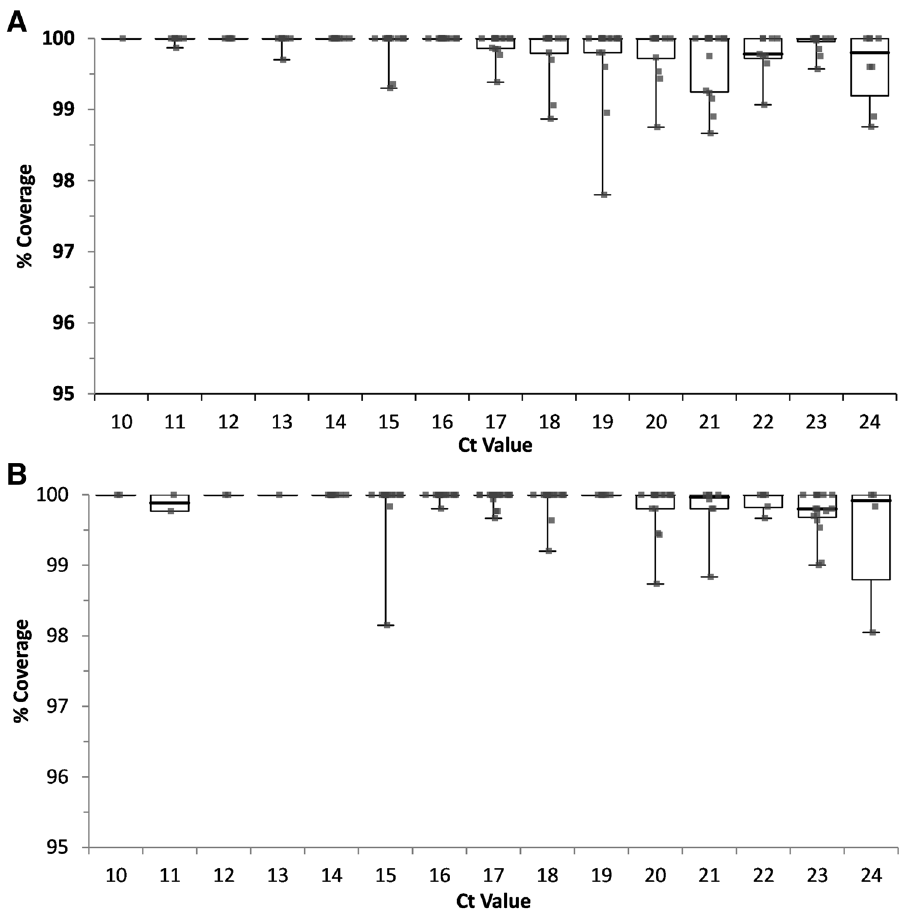
Figure 3. Percent genome coverage for intra-assay ( A ) and inter-assay ( B ) precision samples. Square dots indicate the average percent coverage of the SARS-CoV-2 genome for each replicate. The box plot shows the medians, interquartile ranges (IQR) and 1.5 × IQR at each Ct value. Ct values were rounded